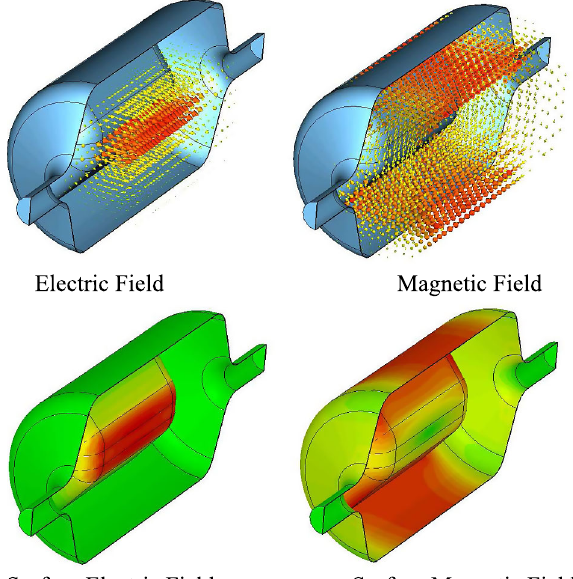
FIG. 26. Field profile and peak surface fields of the rf-dipole cavity with cylindrical outer conductor and trapezoidal-shaped parallel bars [Design (F)].